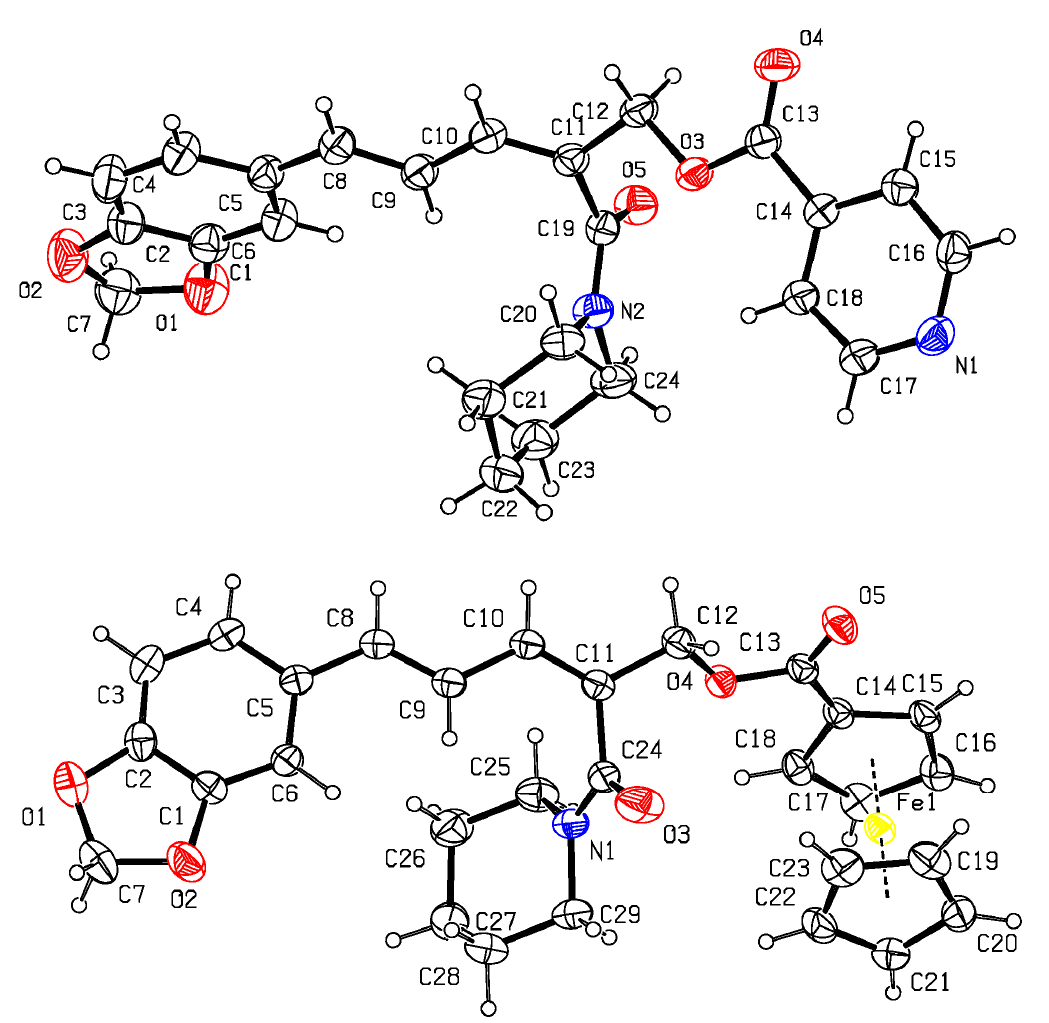
Figure 3. X–ray crystal structures of 6 ( top ) and 7 ( bottom ).